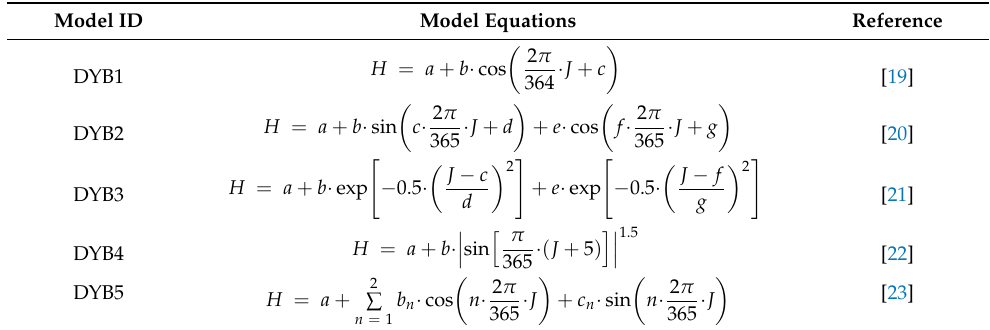
Table 3. Models based on day of the year used in this